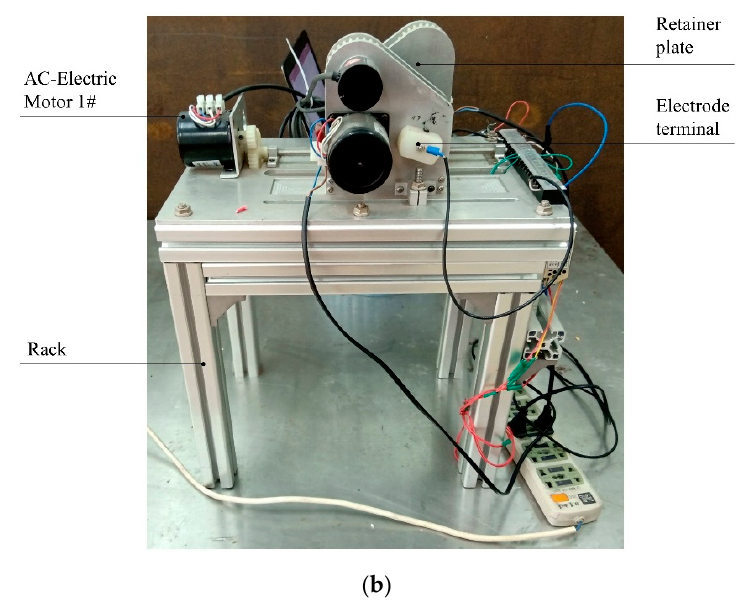
Figure 2. Experimental apparatus for measuring the electrical properties of grains: ( a ) front view; ( b ) left view.